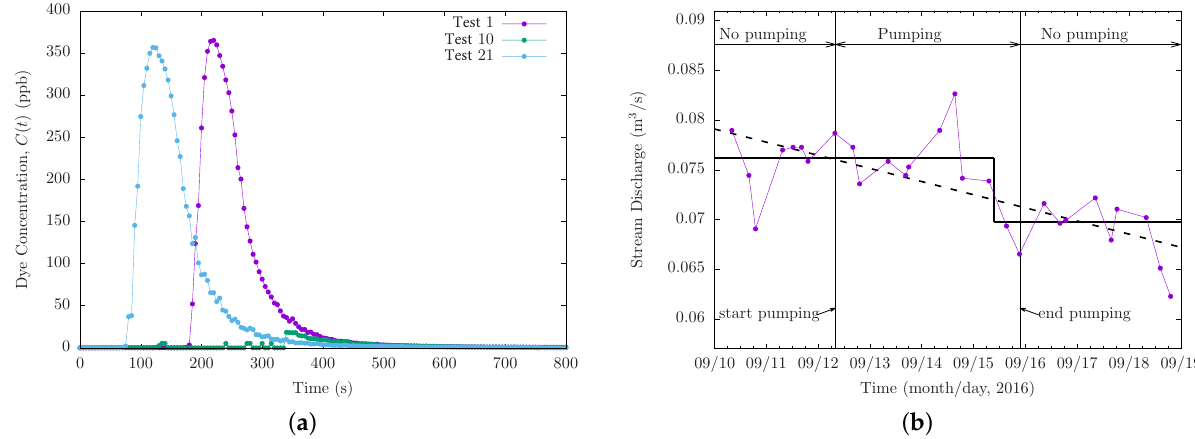
Figure 9. ( a ) Examples of observed time-concentration dye slug test data and ( b ) estimated stream discharge. Two possible interpretations of piecewise constant and steady linear decline in the mean stream discharge are indicated by solid and dashed lines,